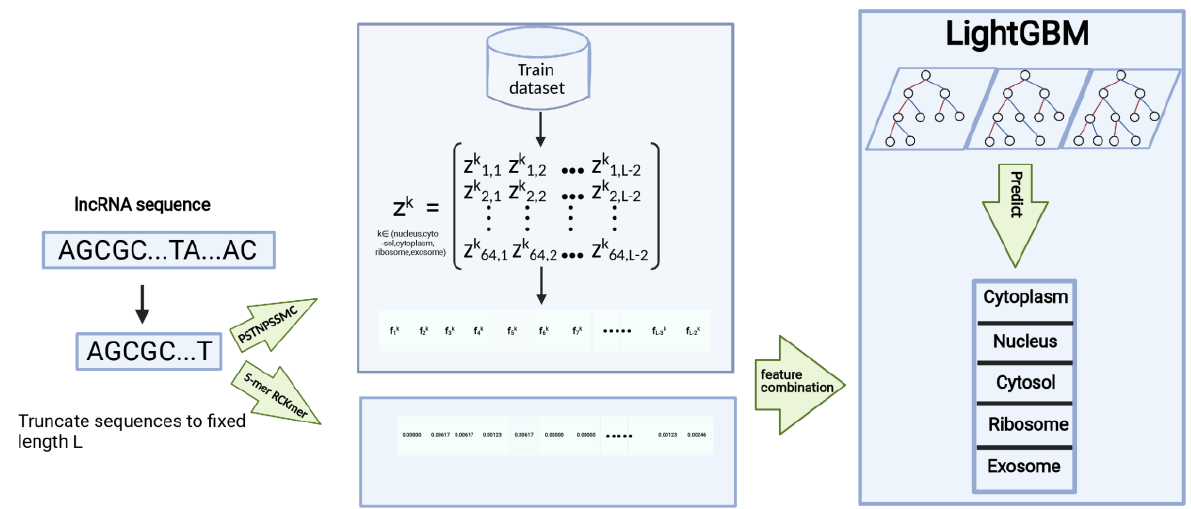
Figure 1. The overview of the proposed LightGBM-LncLoc.